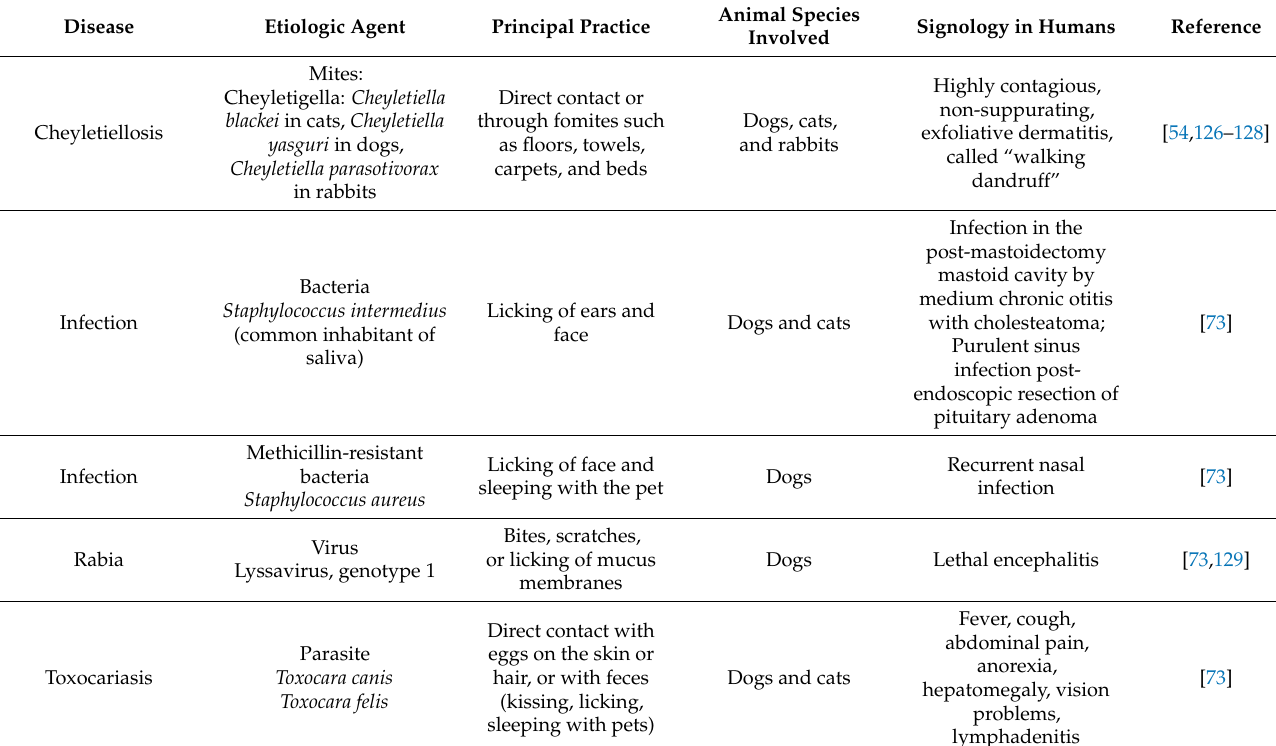
Table 2. Principal zoonoses by pets and the associated risky anthropomorphic